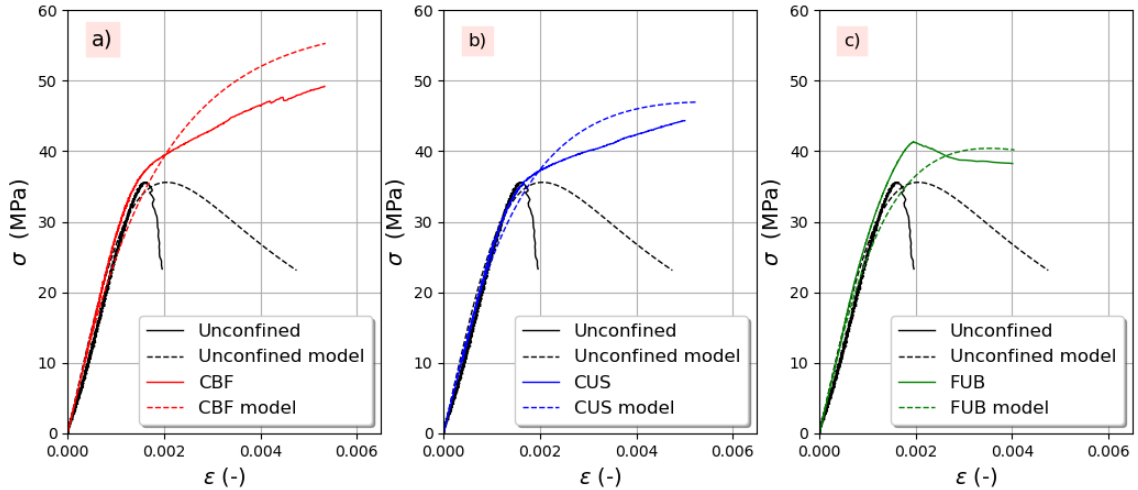
Figure 13. Experimental versus predicted stress–strain curves for concrete without an air-entraining agent: ( a ) CBF, ( b ) CUS, ( c ) FUB.